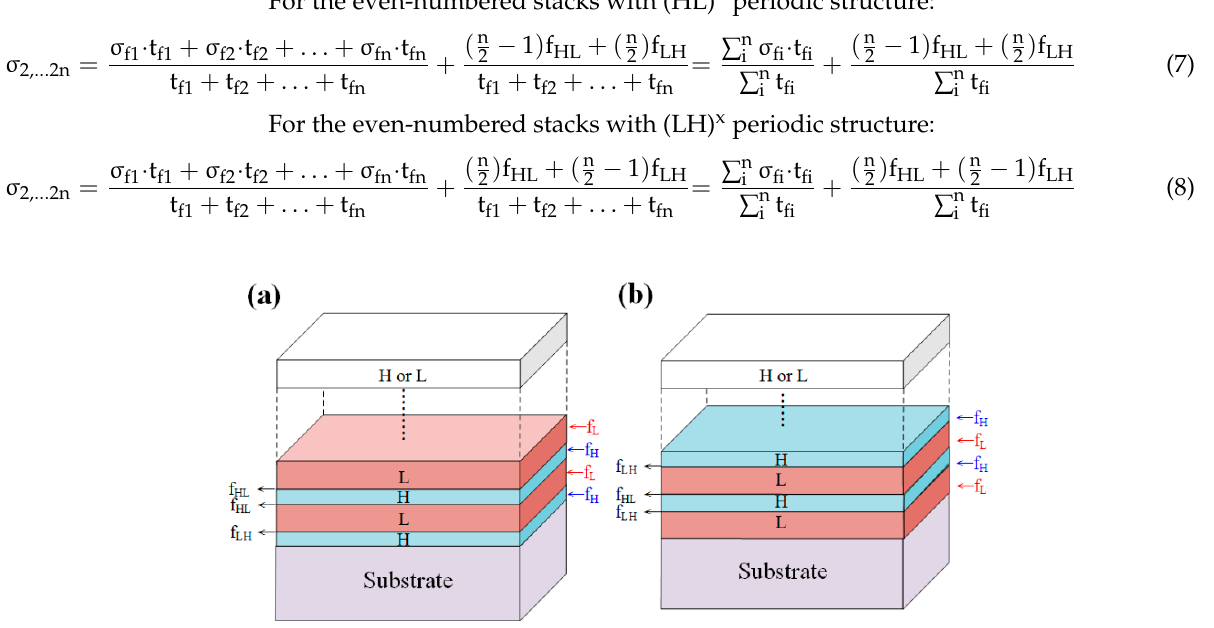
Figure 1. Interfacial force model for ( a ) (HL) x periodic structure; ( b ) (LH) x periodic